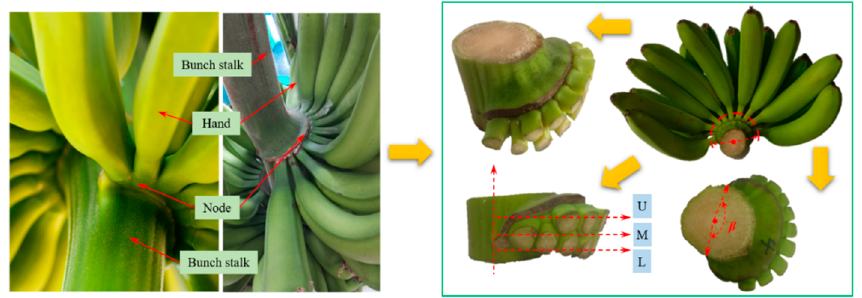
Figure 5. Schematic diagram of measuring the circumferential angle of banana hands.